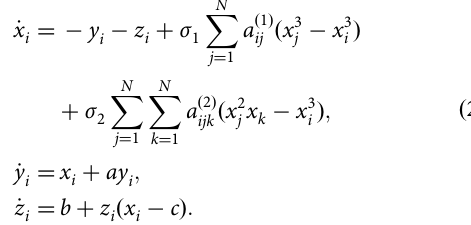
Fig. 6 Synchronization in Zachary karate club structure. Synchronization is studied in simplicial complexes extracted from the interactions characterizing the Zachary karate club network. a Synchronization error (color code reported in the bar at the right of the panel) vs. σ 1 and σ 2 for the simplicial complex obtained when all the triangles are considered as being 2-simplexes. The red line delimits the area of stability of the synchronous solution predicted by the MSF. b λ 2 vs. the percentage of 2-simplexes in the structure, p 2 s (see text for de fi nition); c λ 2 / λ N vs. p 2 s . In b and c three different values of r are considered, with the color code for the plotted curves being reported in the corresponding